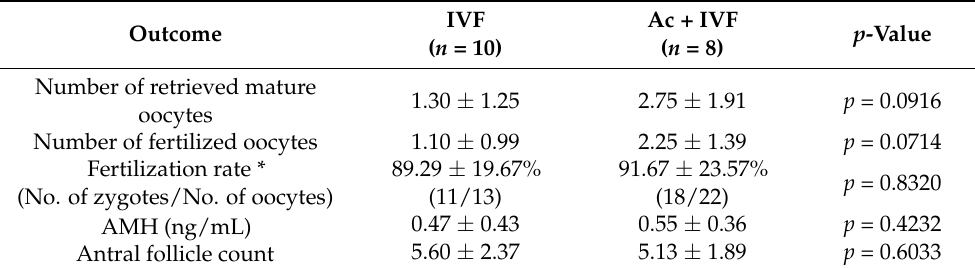
Table 4. Comparison of clinical outcomes in the two study groups. Outcome Number of retrieved mature